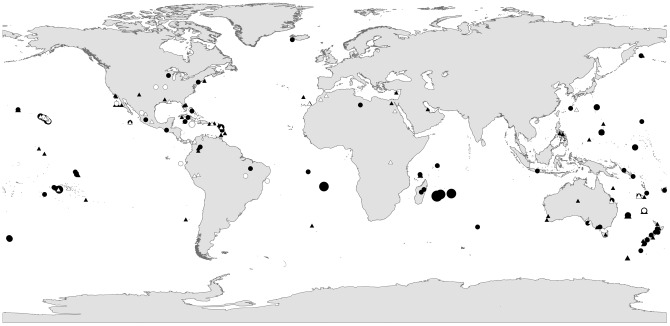
Geographic location of extinctions since 1500.Circles indicate species, triangles indicate subspecies, open symbols indicate ‘Extinct’ taxa, solid symbols indicate ‘Possibly Extinct’ taxa. Larger symbols indicate larger numbers of taxa, as illustrated for species.